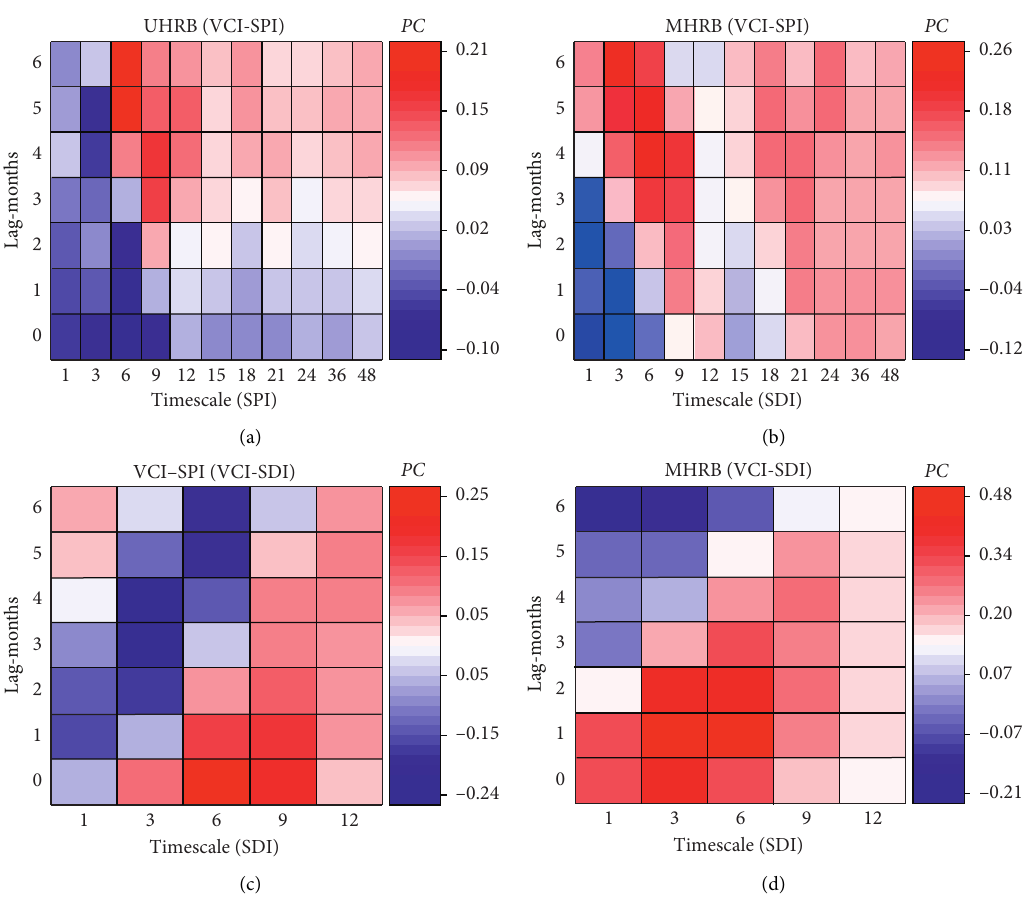
Figure 14: Heat maps showing PC between VCI lagged by 0–6 months and SPI (1-48)/SDI (1-12) for the period of 1999–2012 in the UHRM (Ylx). (a) PC ≥ 0.16, p < 0.05), (b) PC ≥ 0.18 or ≤ ‒ 0.15, p < 0.05) and in the MHRB (Zyx), (c) PC ≥ 0.15, p < 0.05), and (d) PC ≥ 0.16 or ≤ ‒ 0.18, p < 0.05). Table 6: Changes in the area of the primary types of land use and transition matrix and the primary types of land use changes in the UHRB and MHRB (10 4 hm 2